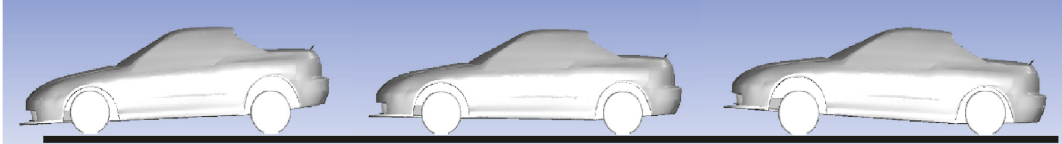
Figure 17: Pitching of the car body due to the elastic suspension system during braking or acceleration.